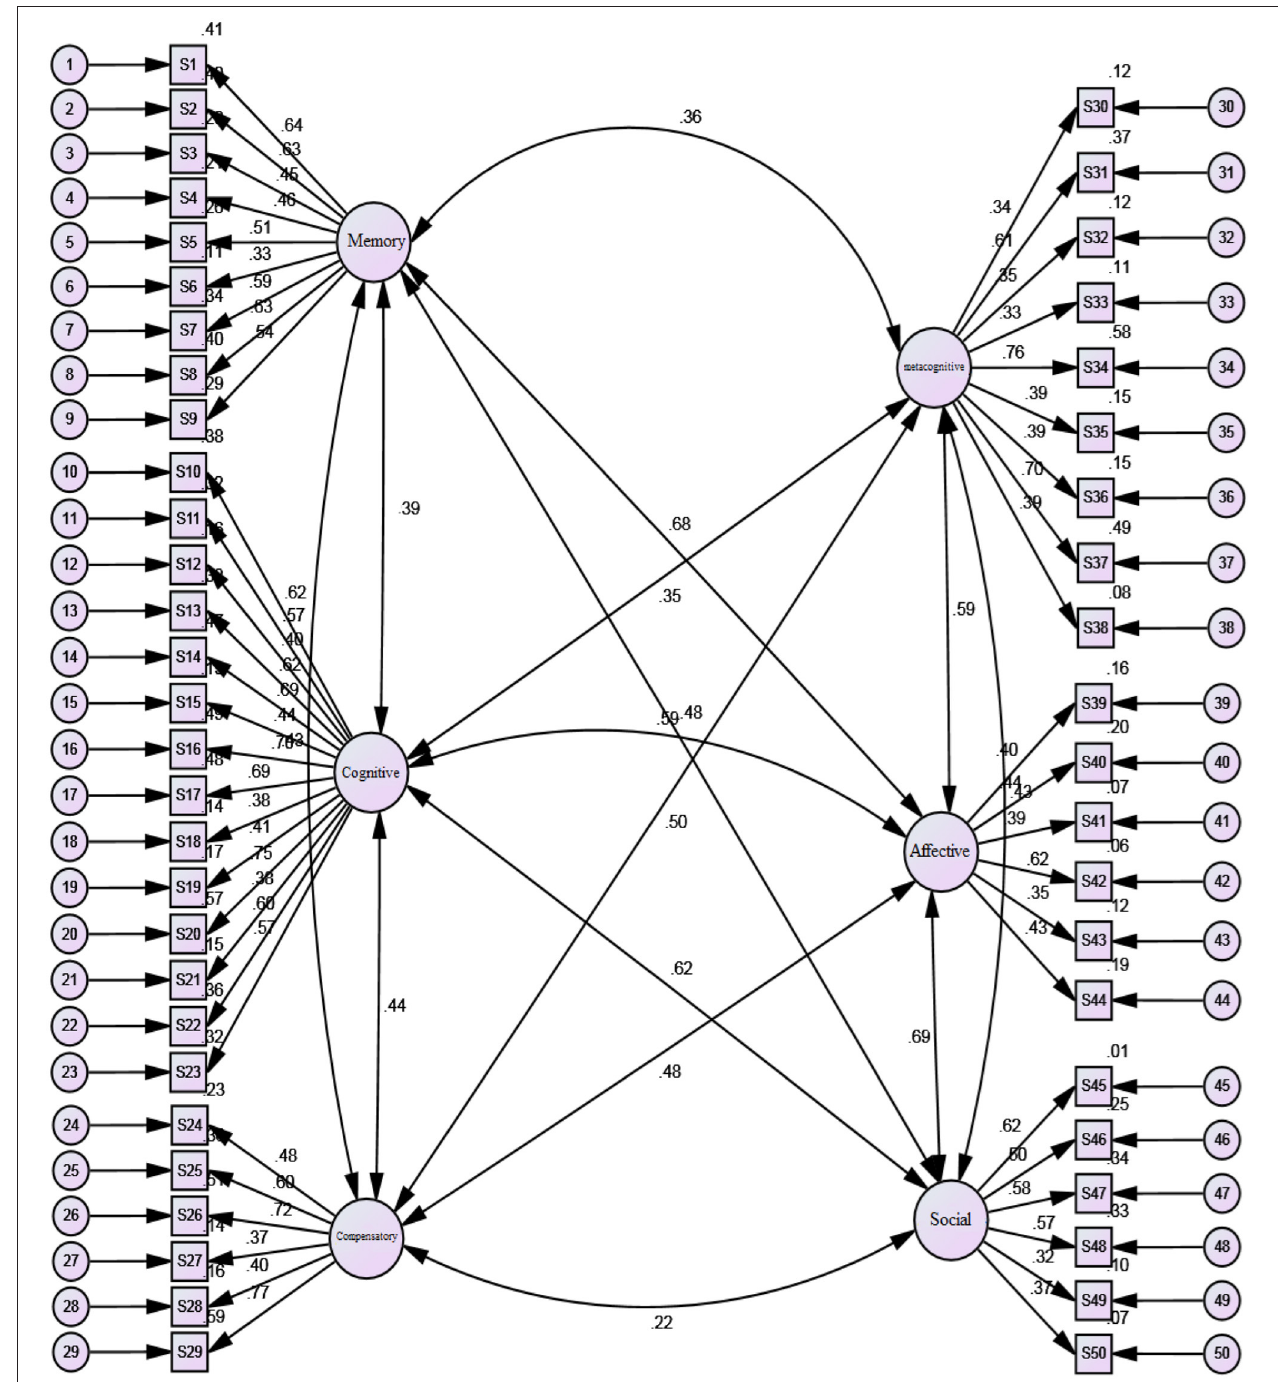
FIGURE 4 | Standardized ( β ) coefficients for CFA analysis and error variance of LLSs.